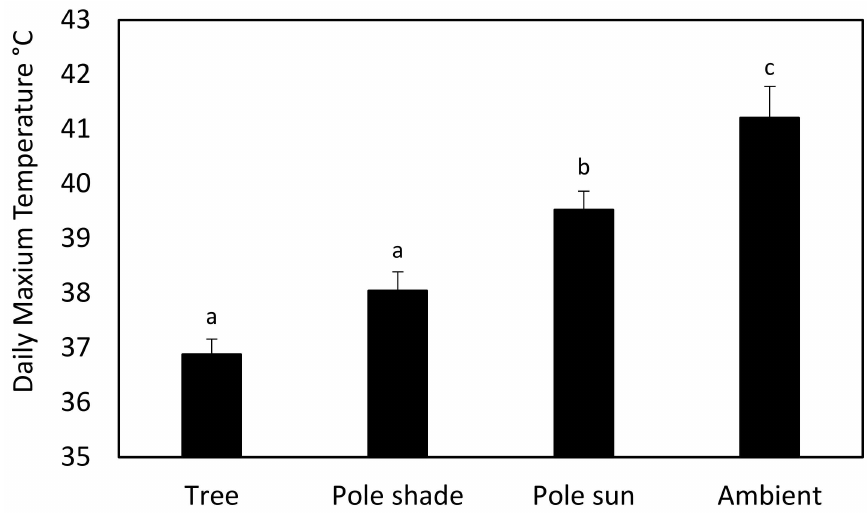
Figure 4. Comparison of the maximum daily temperatures (bar = standard errors) in nest boxes located on trees, on poles in the shade, on poles in the sun, and the outside temperature. Different letters indicate significant differences between nest types (Tukey multiple comparison), p <